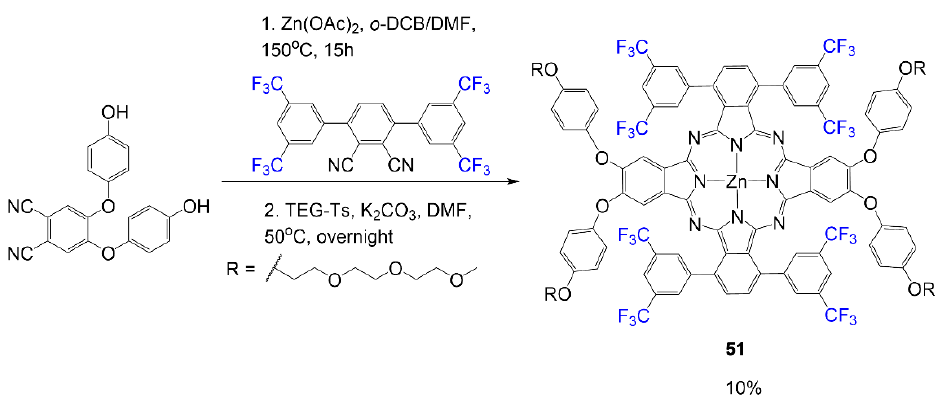
Figure 11. Biological sensing of hydrogen sulfide of dye 29 [41]. Fluorescence spectra ( left ) of 1 µM of dye 29 at concentrations 0 – 125 µM of hydrogen sulfide. Inset indicates a linear relationship be- tween fluorescence and increasing concentrations of hydrogen sulfide. Confocal microscopy ( right ) of HEK293A cells incubated in 1 µM of dye 29 and two concentrations of sodium sulfide, 50 µM and 200 µM, respectively. Top images show fluorescence without the aid of a bight field. Scale bar: 50 µm. Figure used with permission from [41]. Copyright 2015 Royal Society of